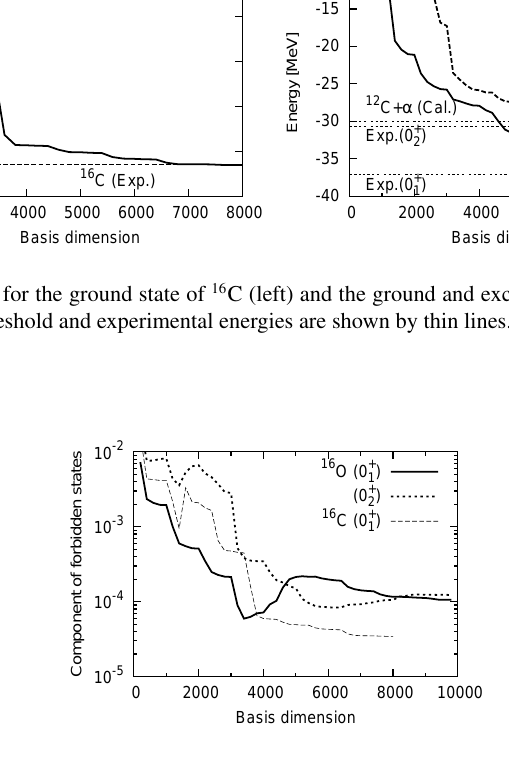
Figure 2. Components of the forbidden states in the A = 16 wave functions as a function of basis